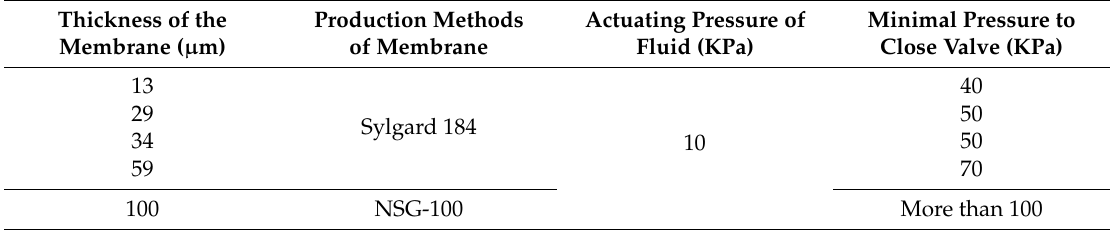
Table 3. Minimal pressure to close the valve without bubble generation in different membrane